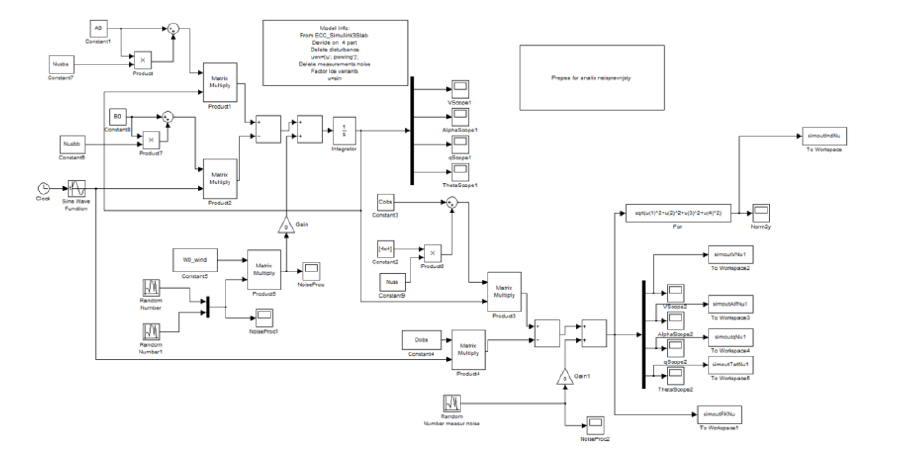
Fig. 3 . Simulink model based on the effects of icing factors